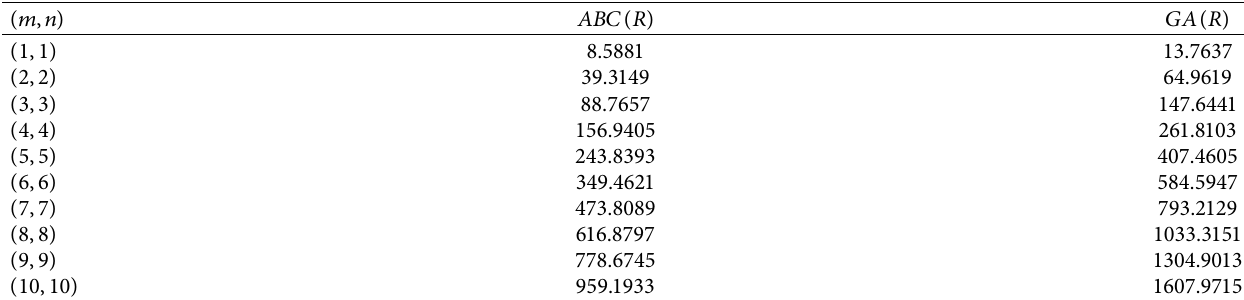
Table 5: Connection between ABC ( R ) and GA ( R